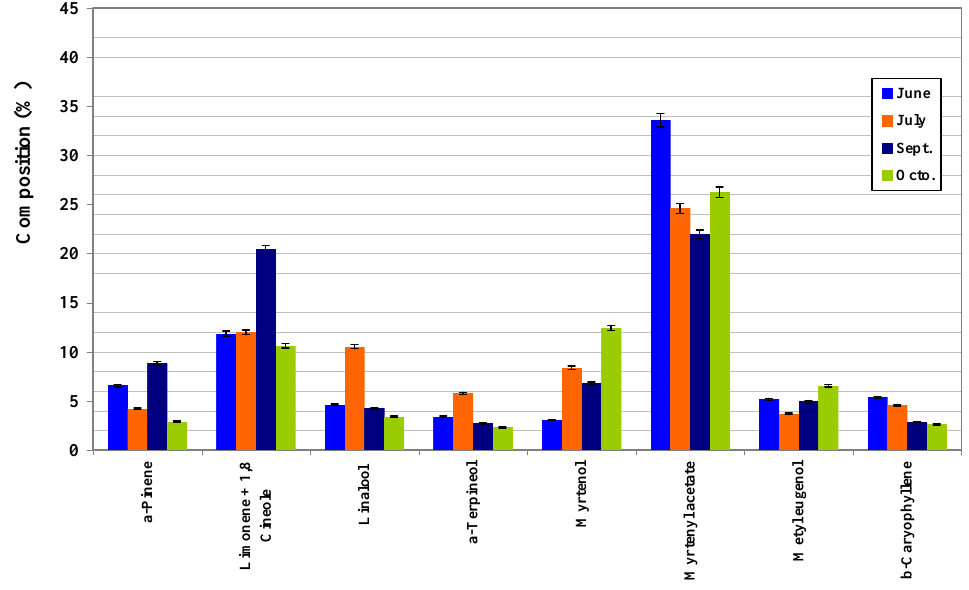
Figure 2 . Composition of main compounds of branches essential oil of Portuguese myrtle.